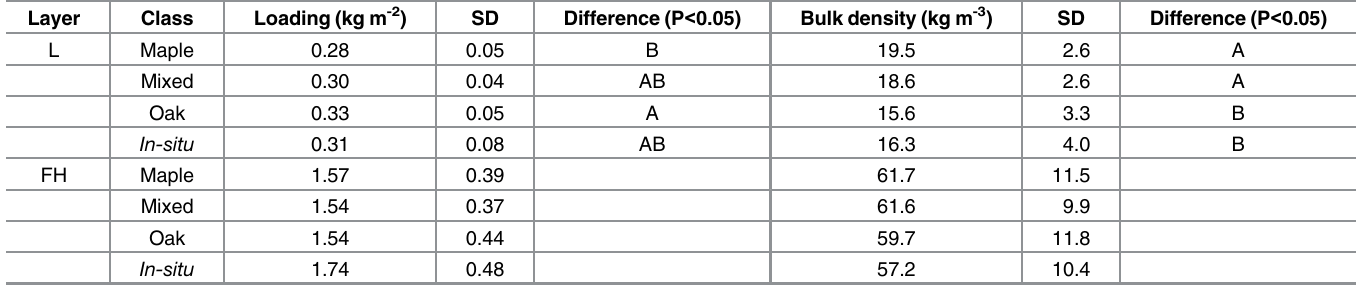
Table 3. Mean L- and FH-layer loading and bulk density on common garden beds and in situ beds after four years of fall replenishment. Layer Class Maple